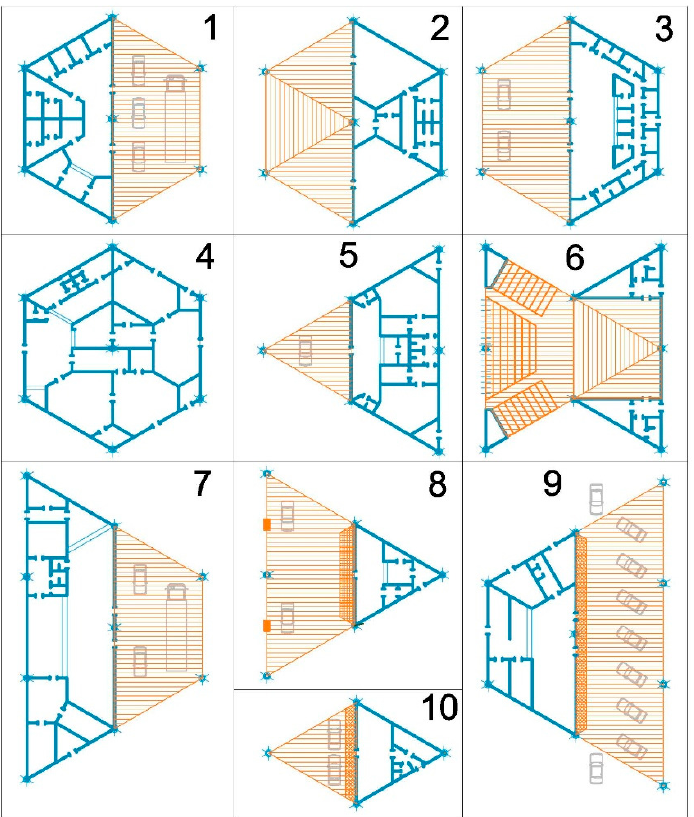
Figure 6. Planning solutions: 1—the Heating point; 2—the Children’s play area; 3—the Post office;